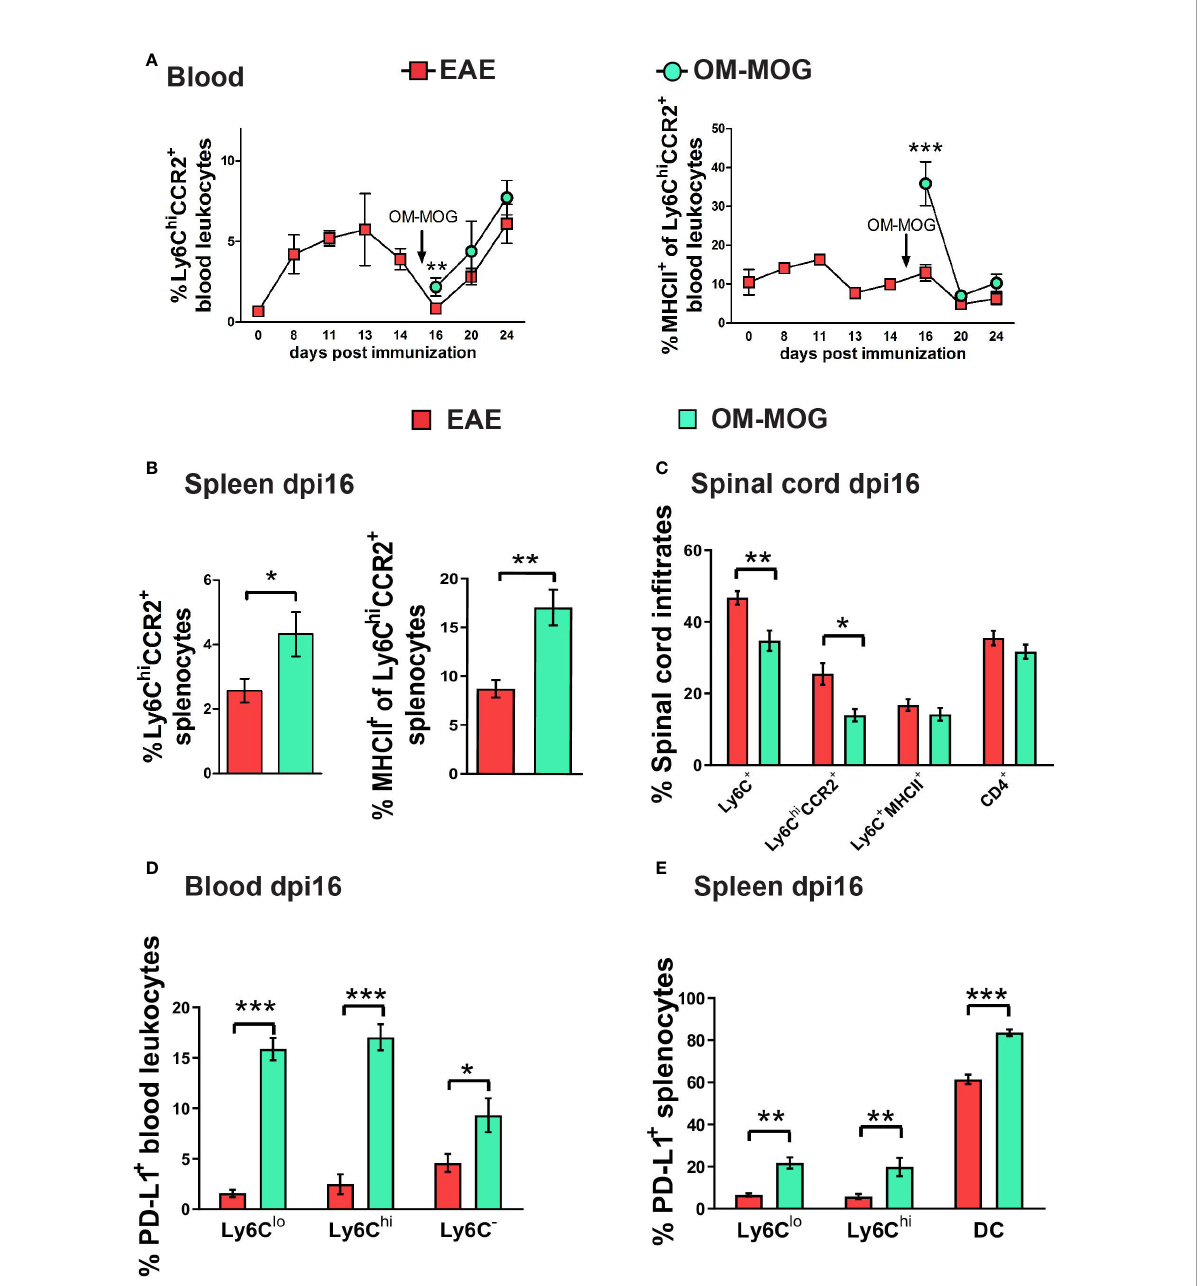
FIGURE 5 Therapeutic OM-MOG alternatively activates and retains Ly6C hi CCR2 + monocytes in the periphery of EAE mice, while inhibiting in fi ltration of the spinal cord. (A) Time-course of proportions of Ly6C hi CCR2 + monocytes (left graph) and Ly6C hi CCR2 + monocytes expressing MHCII (right graph) in blood of EAE mice treated therapeutically with vehicle or OM-MOG from dpi 15 (arrow) every two days (n=3 at day 0 and n=3-10/ group/time-point). (B) Proportions of Ly6C hi CCR2 + monocytes (left graph) and Ly6C hi CCR2 + monocytes expressing MHCII (right graph) in spleen of EAE mice at disease peak (dpi 16) 24 hours after 1 therapeutic injection of vehicle (EAE) or OM-MOG 15 (arrow in A ). (C) Proportions of Ly6C hi CCR2 + and Ly6C + MHCII + cells and CD4 + T cells in CNS-in fi ltrating mononuclear cells recovered from spinal cord of mice shown in A at disease peak (dpi 16) 24 hours after 1 therapeutic injection of vehicle (EAE) or OM-MOG (n=8 for EAE and n=4 for OM-MOG). Proportions of PD-L1-producing, (D) CD11c - Ly6C lo , CD11c - Ly6C hi myeloid cells and Ly6C - cells in blood (n=6 for EAE and n=4 for OM-MOG), and (E) CD11c - Ly6C lo , CD11c - Ly6C hi myeloid cells and CD11c + Ly6C - DC in spleen (n=8 for EAE and n=4 for OM-MOG) of mice shown in A at disease peak (dpi 16) 24 hours after 1 therapeutic injection of vehicle (EAE) or OM-MOG. Data and statistical analysis are from one experiment. Statistical signi fi cance is shown after pairwise comparisons between groups using Student ’ s t test (*p ≤ 0.05, **p ≤ 0.01, ***p ≤